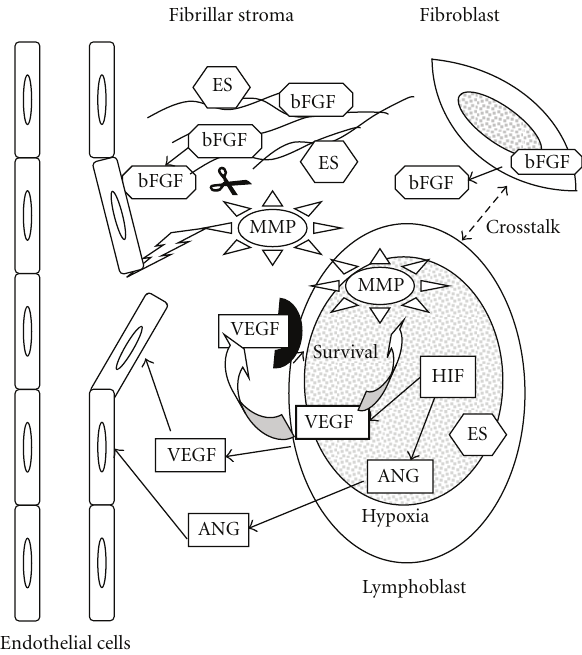
Figure 1: Interactions between leukemic cells (lymphoblasts) and some of the BM components. Leukemic cells and endothelial cells produce vascular endothelial growth factor (VEGF), and basic fibroblast growth factor (bFGF) is produced by fibroblasts. VEGF plays a key role in vessel growth but also in blood vessel survival. Through its autocrine loop, VEGF enhances lymphoblast survival. The matrix metalloproteases secreted by lymphoblasts degrade the extracellular matrix and liberate growth factors such as bFGF. Hypoxia induces, via the HIF-1 α subunit, the expression not only of VEGF but also of angiopoietin 2 (ANG). Endostatin (ES) is expressed by leukemic and stromal